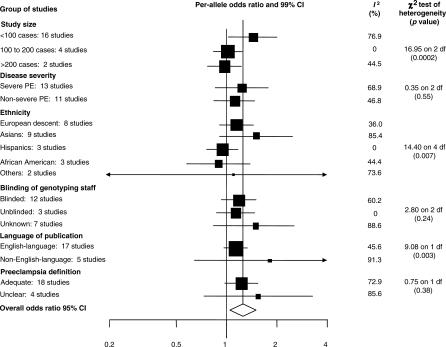
Studies of ACE-I/D Polymorphism and Risk of Preeclampsia Grouped by Study Characteristics